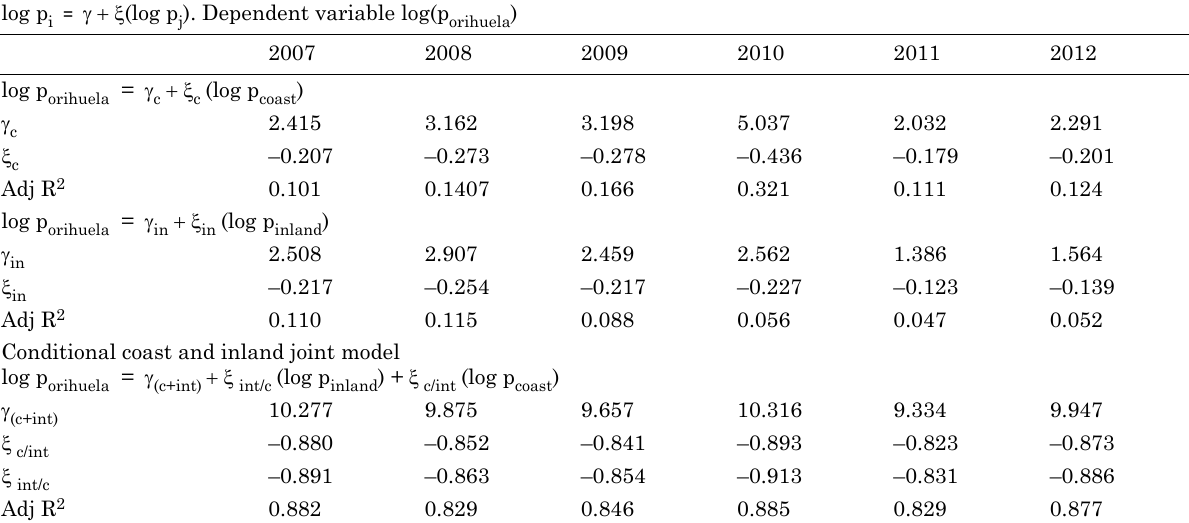
Table 2. Relative price models estimation. Parameters value and explanatory capacity